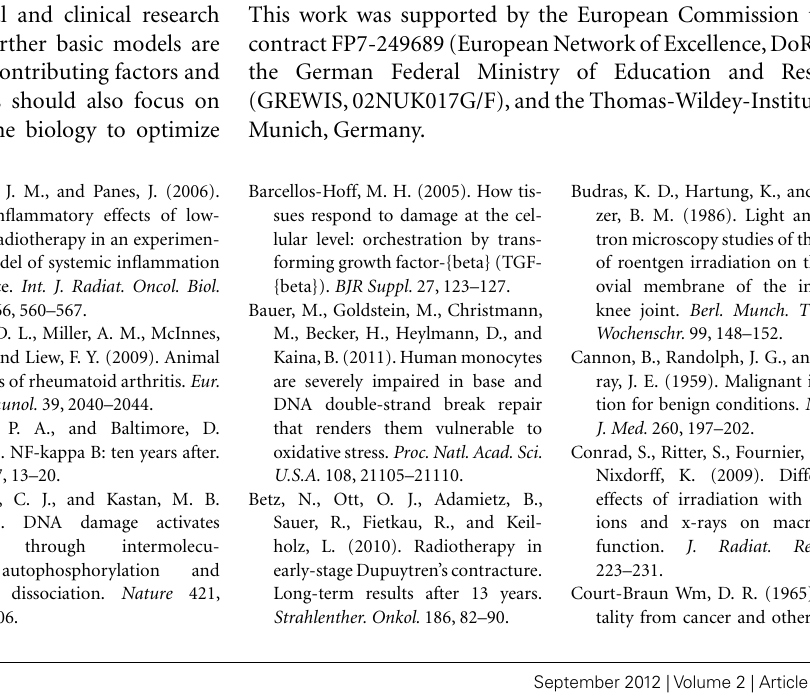
FIGURE 1 |Actual model on the modulation of inflammatory cell activity and factors involved in the anti-inflammatory effect of LD-RT ( < 1Gy). Irradiation resulted in a hampered adhesion of peripheral blood mononuclear cells (PBMC) to the endothelium, due to the secretion of the anti-inflammatory cytokine transforming growth factor β 1 (TGF- β 1), a decreased expression of E-selectin on the surfaces of endothelial cells, a local increase of apoptosis, and the proteolytic shedding of L-selectin from PBMC. In stimulated macrophages a diminished activity of the inducible nitric oxide